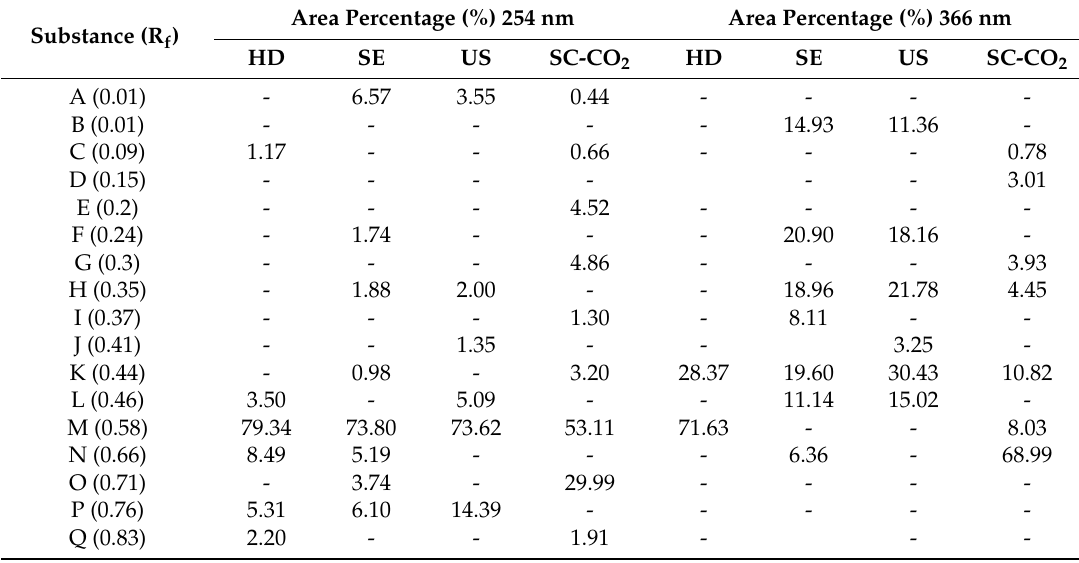
Table 3. Substance A–Q with their R f and area percentage of T. ammi essential oil obtained by different extraction techniques.